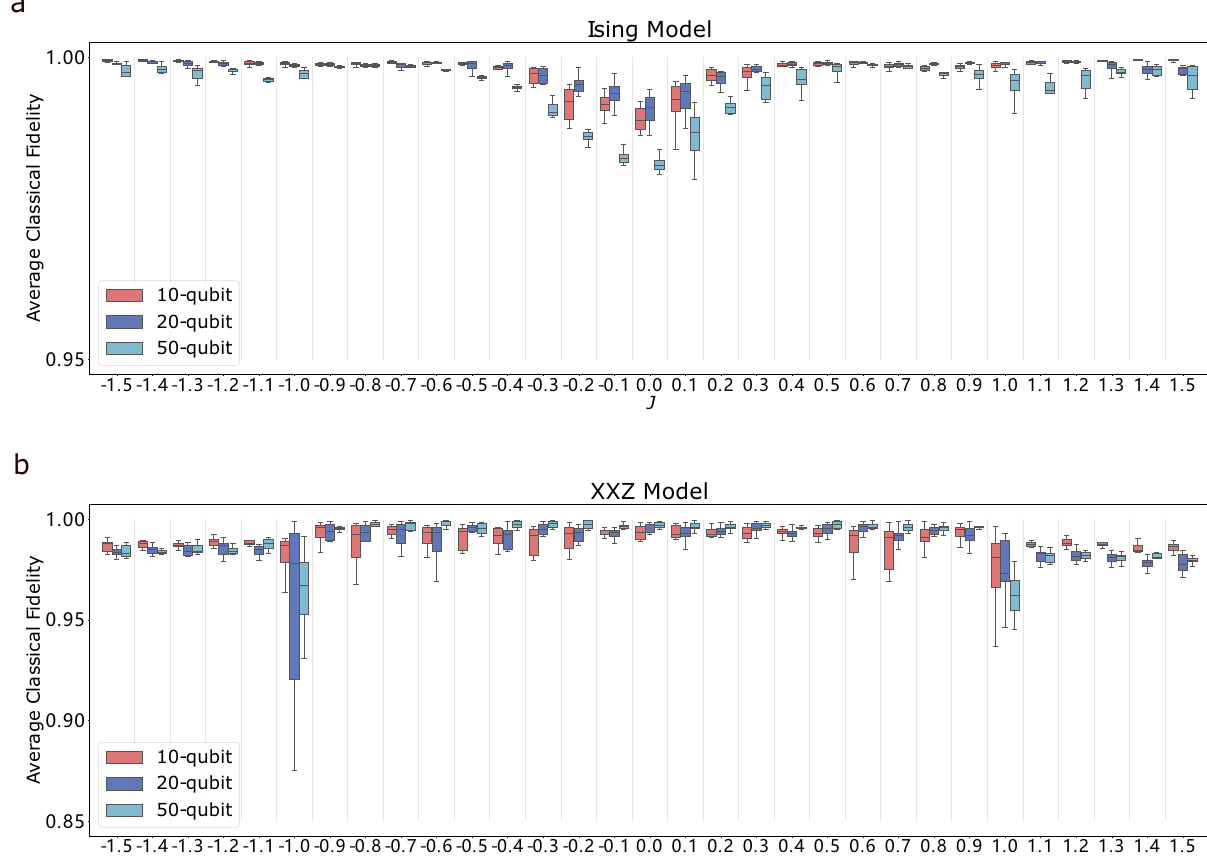
Fig. 2 | Performance of GQNQs on Ising model ground states and XXZ model ground states visualized by boxplots 49 . Figure a shows the average classical fi delities of predictions given by three GQNQs for ten-, twenty- and fi fty-qubit ground states of Ising model (1), respectively, with respect to different values of J ∈ { − 1.5, − 1.4, … ,1.5}. Figure b shows the performance of another three GQNQs for